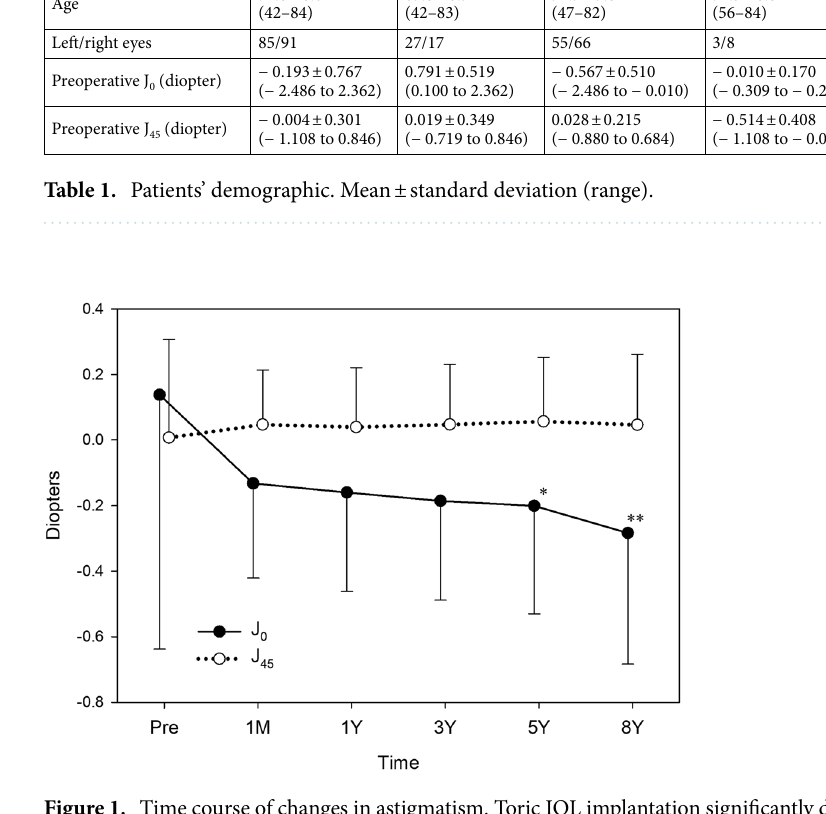
Figure 1. Time course of changes in astigmatism. Toric IOL implantation significantly decreased J 0 ( p = 0.002), but not J 45 ( p = 0.902). When postoperative values from 1 month to 8 years were compared, statistically significant changes were found in J 0 ( p < 0.001) but not in J 45 ( p = 0.743). The J 0 at 5 years (* p = 0.008) and 8 years (** p < 0.001) were significantly smaller than J 0 at 1 month postoperatively.